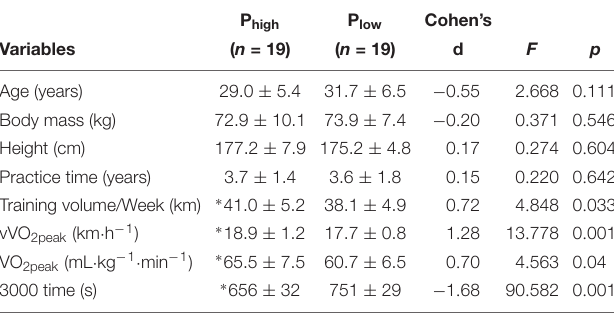
TABLE 1 | Means and standard deviation of sample characterization for high- and low-performance groups. P